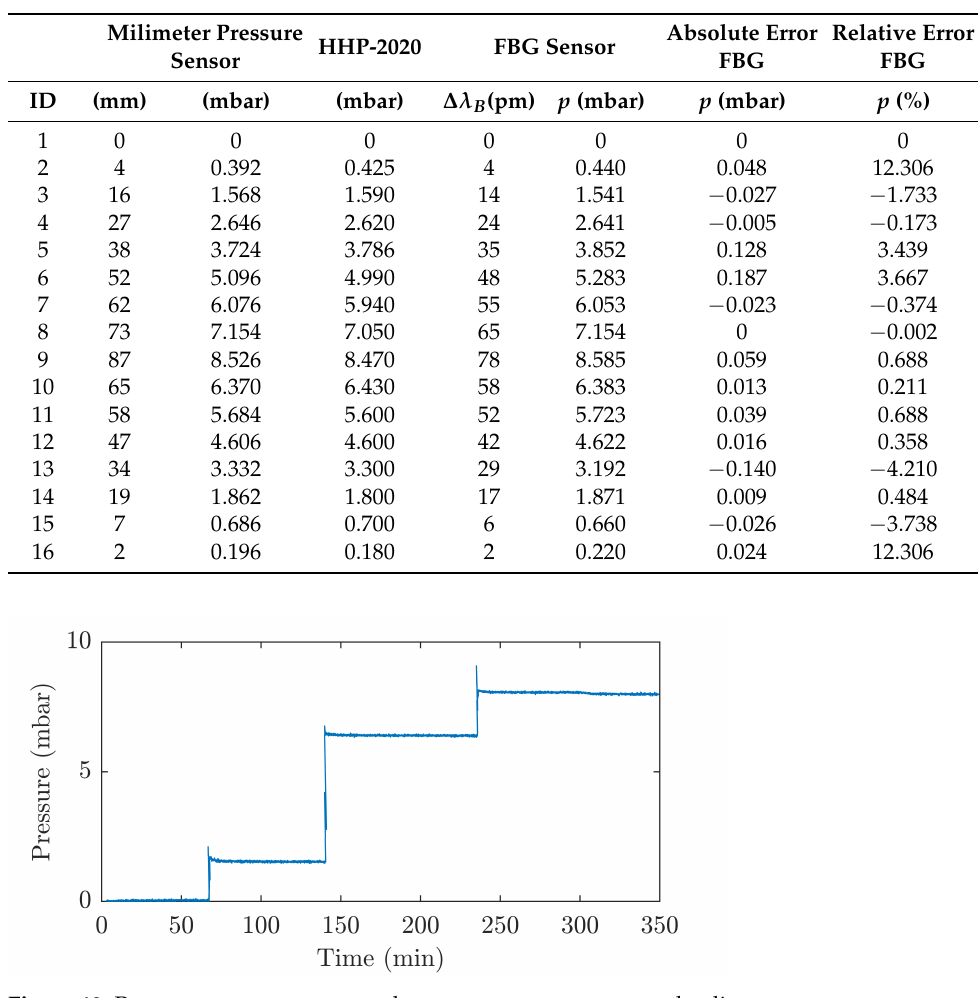
Figure 10. Pressure sensor response to long-term constant pressure loading. Figure 11 shows the variance of the measured data in each sensor load condition. For better visualization, the mean value is removed from the measured data. The results show that the sensor is capable of measuring static pressure with a deviation of ± 0.1 mbar. In the range of 0 to 10 mbar, this represents a deviation of 10% for pressures close to 0 and 1% for pressures close to 10 mbar.